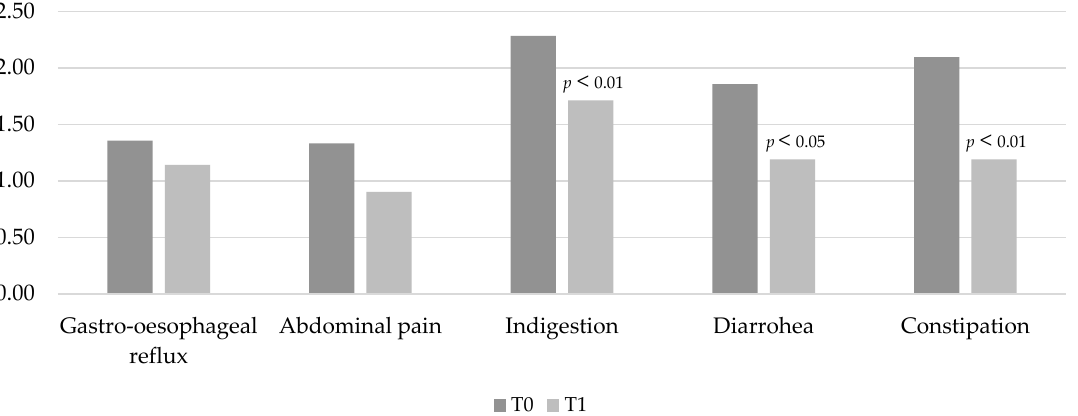
Figure 3. Characteristics of GI manifestations by GSRS (constipation, diarrhoea, indigestion, abdominal pain, gastro-oesophageal reflux) in patients on low- FODMAP diet before (T0) and after Phase 1 of the protocol